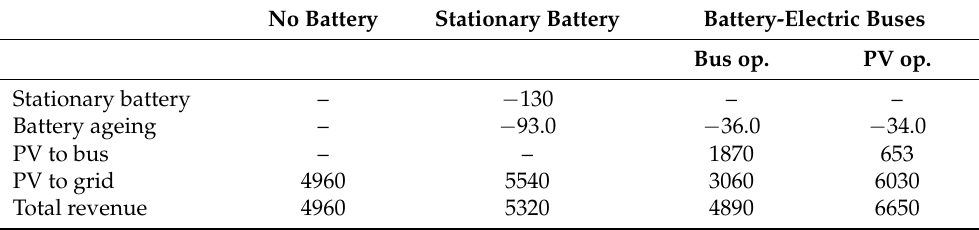
Table 7. Revenue comparison for the PV operator considering no storage, stationary batteries (2% of the installed PV capacity i.e., 27kWh), and BEBs (in SGD) for a ramp rate limit of 1%. The ramping costs are not deducted from the total revenue, as they are implicitly included in the lower revenue for PV to battery, bus, or grid for one week. No Battery Stationary Battery Battery-Electric Buses Bus op. PV op. Stationary battery – − 130 – – Battery ageing – − 93.0 − 36.0 − 34.0 PV to bus – – 1870 653 PV to grid 4960 5540 3060 6030 Total revenue 4960 5320 4890